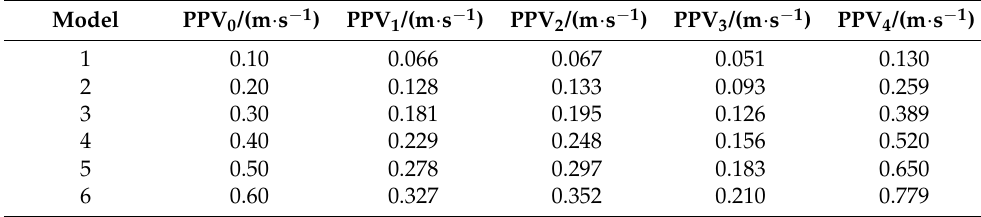
Table 6. Model design with different PPVs.